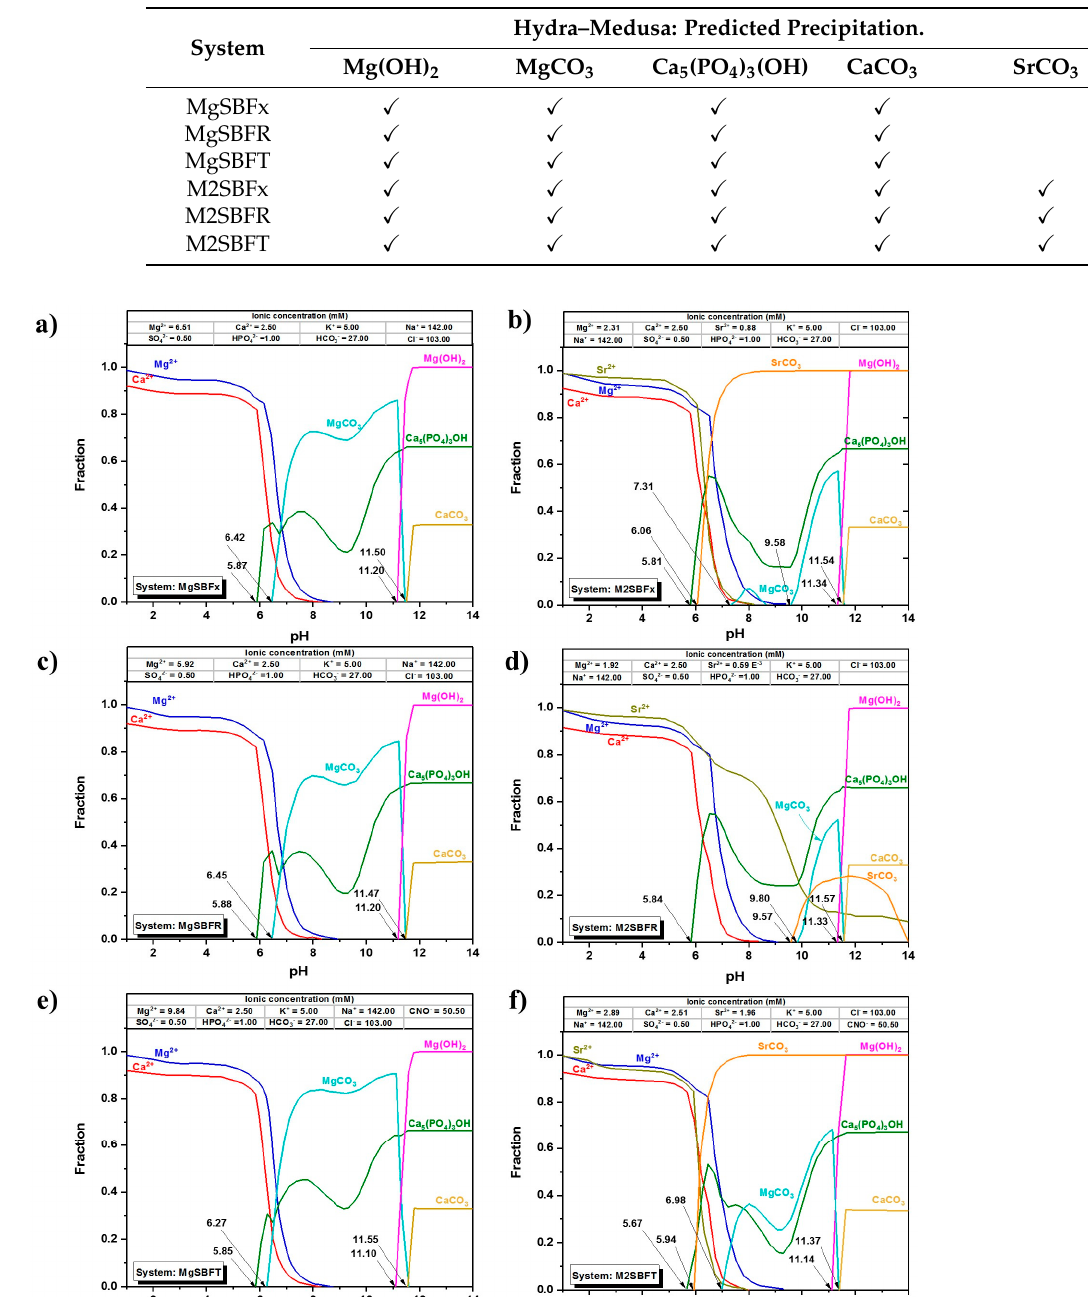
Figure 8. Simulated Hydra–Medusa diagram of either Mg 2+ , Ca 2+ , or Sr 2+ fraction against pH value based on thermodynamic constant. ( a , c , e ) display the simulated diagram with predicted corrosion products of CP Mg in r-SBF solution under three treatment conditions. ( b , d , f ) illustrate the possible precipitate that resulted from Mg-1.0Ca-0.5Sr alloy immersion. The labelled pH values indicate the minimum pH value to initiate the formation of Mg(OH) 2 , Ca 5 (PO 4 ) 3 OH, MgCO 3 , CaCO 3 , and SrCO 3 . The summarized possible corrosion products in different corrosion media and pH-regulating conditions are listed in Table 6.